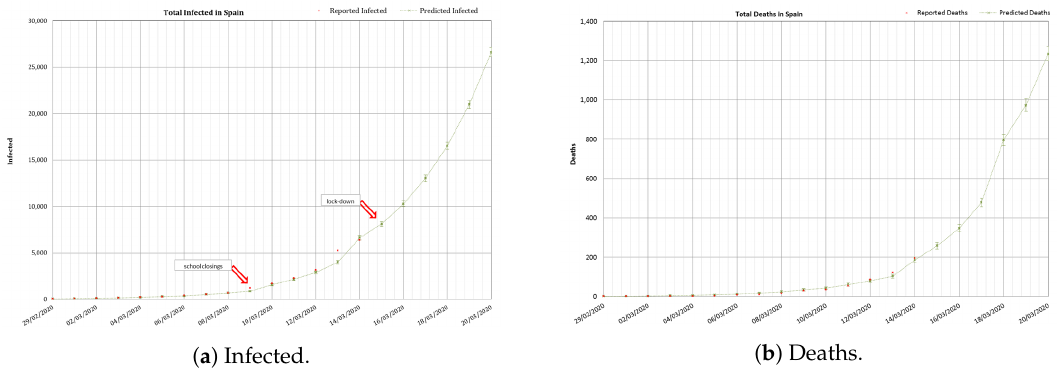
Figure 5. Predicted number of infected ( a ) and deaths ( b ) in Spain from 29 February/20 March. The data from the 14 March are based in the model assuming no interventions were implemented. Red dots—reported. Green bars—modelled with